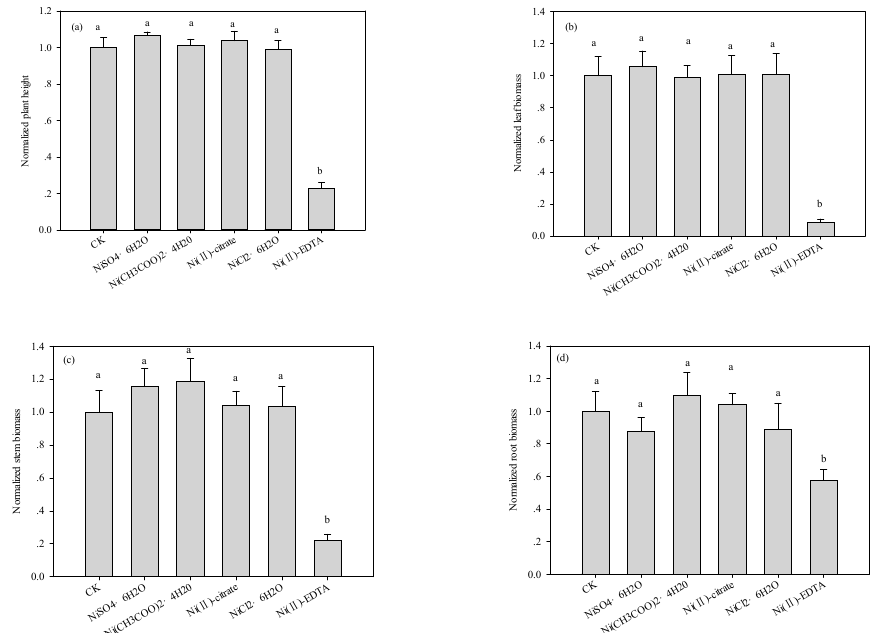
Figure 1. Effects of different Ni compounds added to soil (560 mg·Ni kg − 1 ) on the ( a ) plant height, ( b ) leaf biomass, ( c ) stem biomass, and ( d ) root biomass of maize seedlings at 28 days after emergence. The normalized values for the different treatments were calculated in reference to the control (CK), and the error bars represent standard the errors of the means. Values with different letters are significantly different (Duncan multiple range test, p = 0.05).